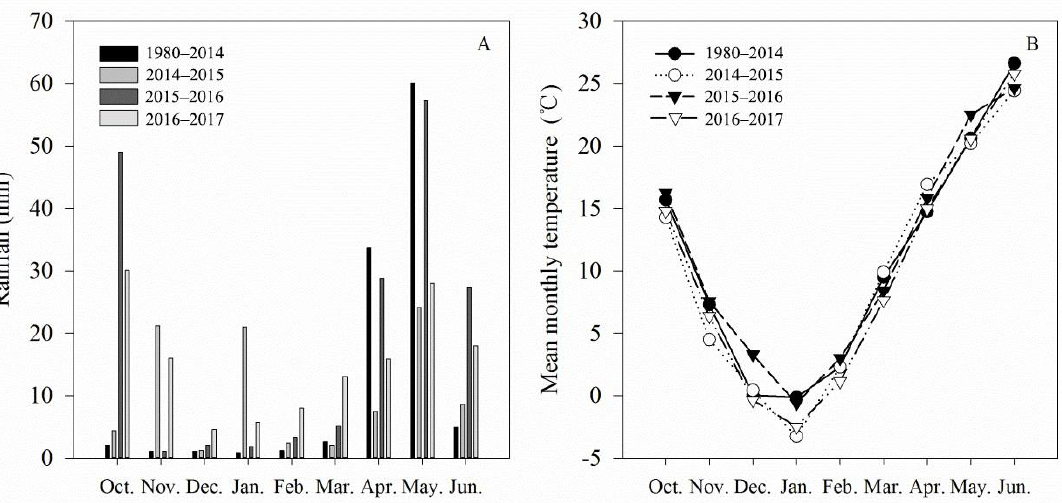
Figure 1. Rainfall ( A ) and mean monthly temperature ( B ) during the wheat growing season (from the initial year in October to the next year in June). Table 1. Changes in soil organic carbon (SOC), total nitrogen (TN), the carbon/nitrogen ratio (C/N) and other chemical parameters in the period from before wheat sowing in 2014 to after wheat harvest in